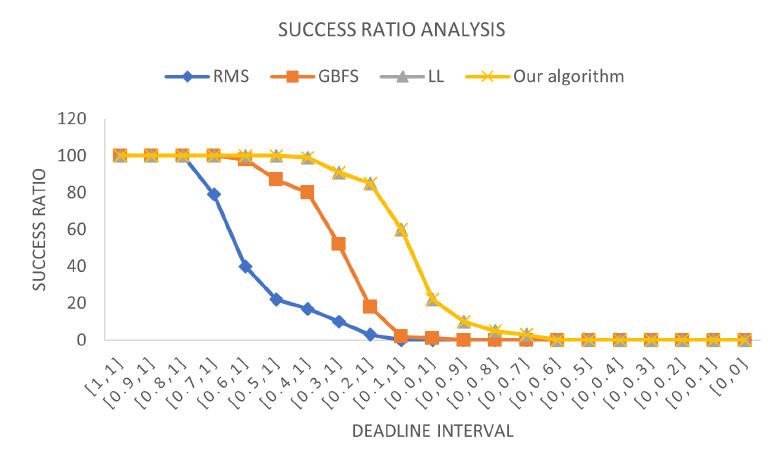
Figure 6. Success ratio vs.